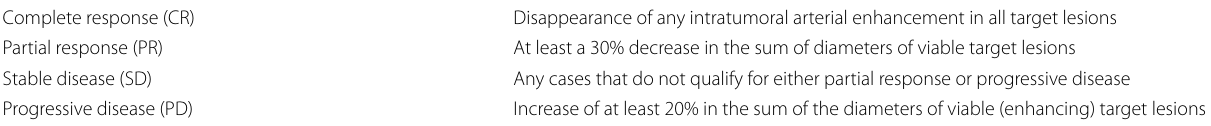
Table 1 mRECIST criteria Complete response